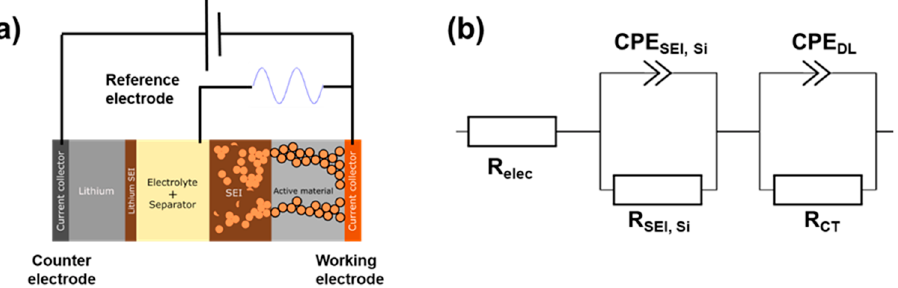
Figure 4. ( a ) Scheme of the cell in a three electrodes configuration; ( b ) the corresponding equivalent electrical circuit to model and fit raw data from measurement.